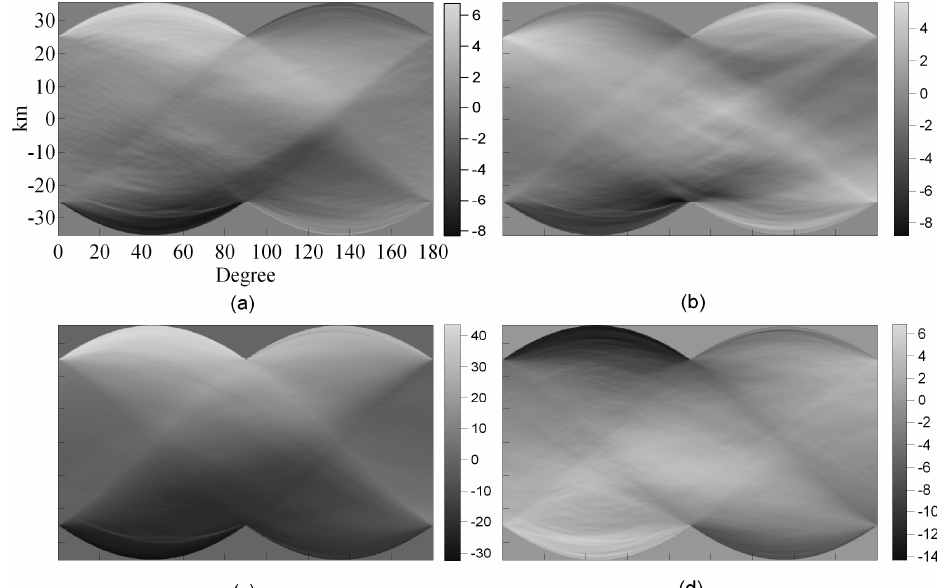
Figure 3 . Radon transform of atmospheric signals in SAR pairs acquired on: (a) 19 and 20 February, 1996, (b) 25 and 26 March, 1996, (c) 3 and 4 June, 1996, and (d) 16 November and 21 December, 1999 (from Li et al .